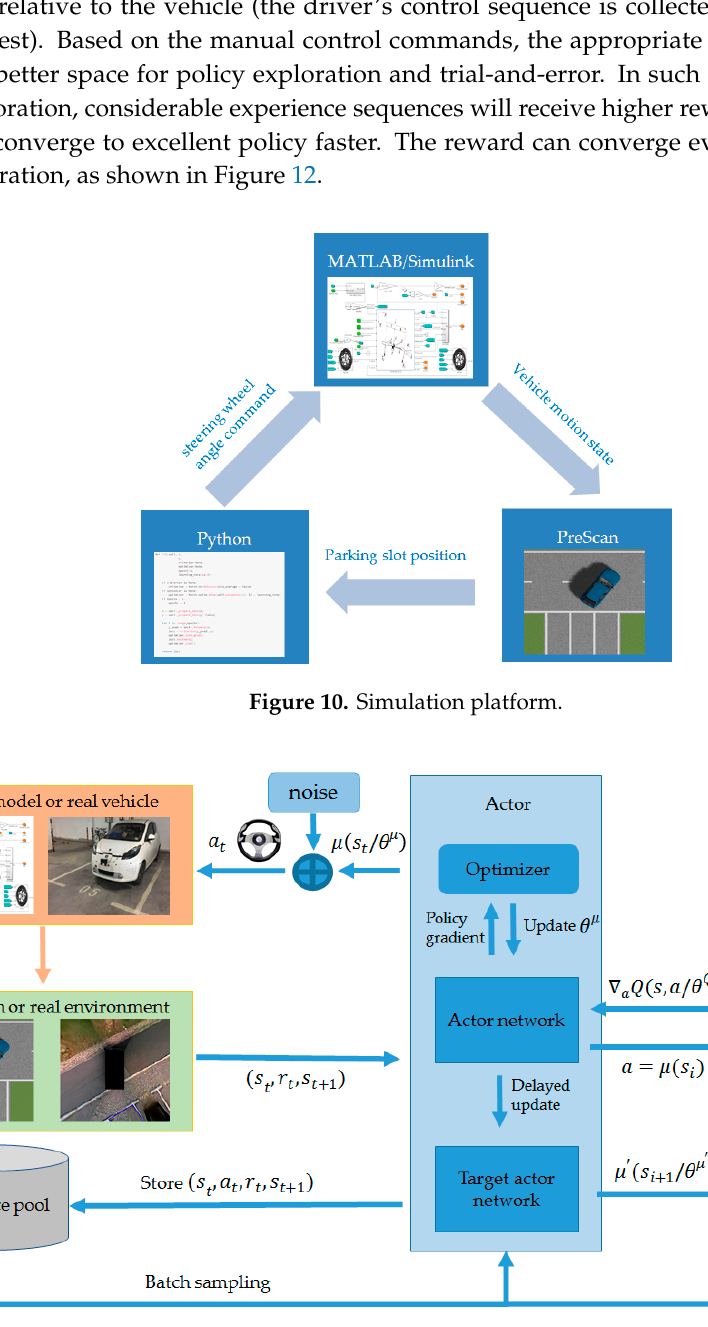
Figure 11. The training architecture of DDPG.